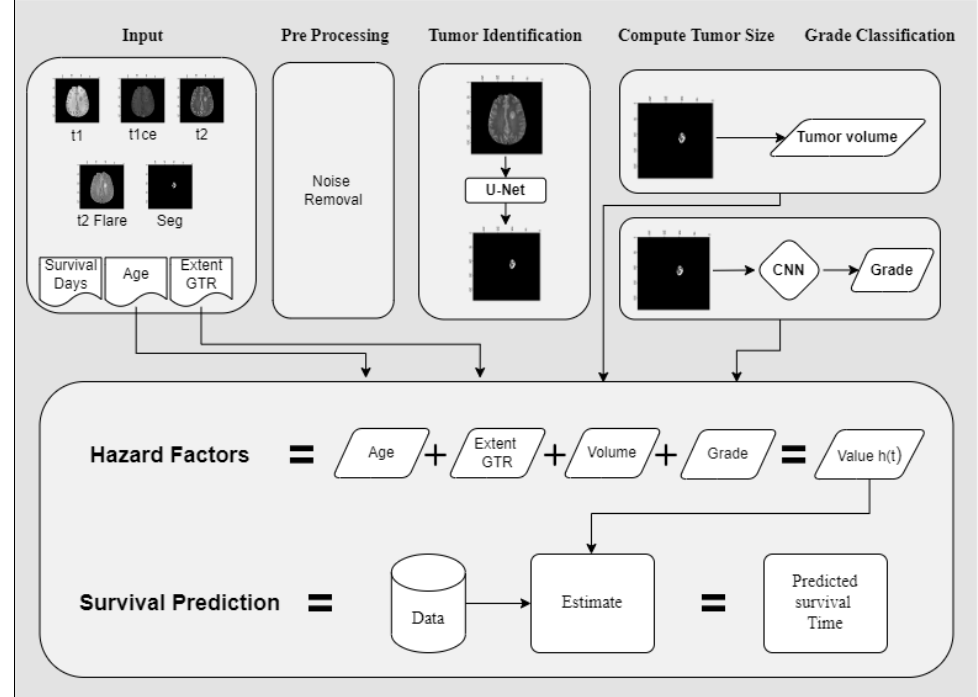
Figure 1. Procedural flowchart of the proposed ETISTP model.